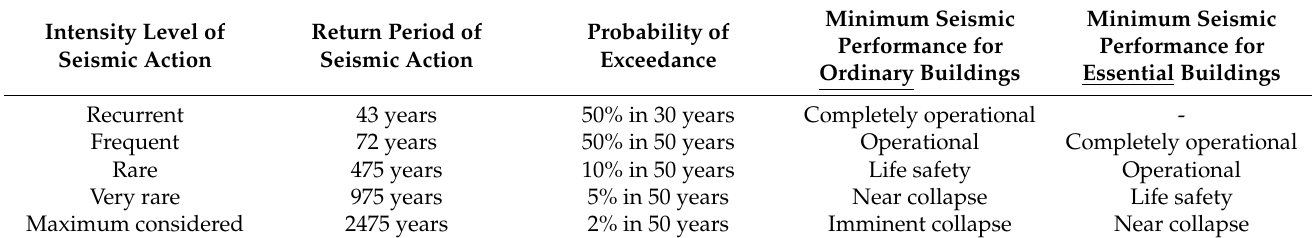
Table 4. Definition of performance objectives for current and essential buildings (adapted from [26]).